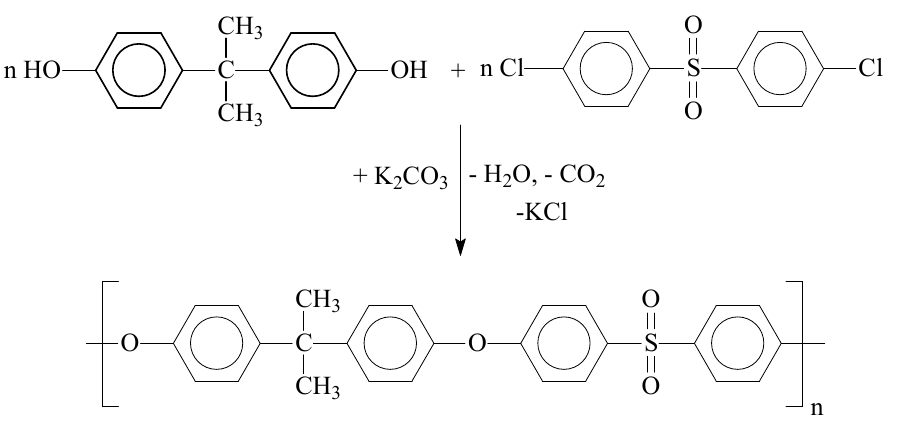
Figure 1. PSF synthesis scheme. Table 2. Synthesized PSF samples and synthesis conditions.